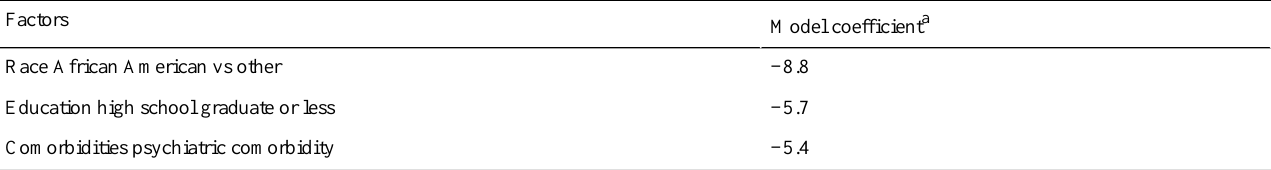
Table 2. Predictors of adherence using stepwise multivariate linear